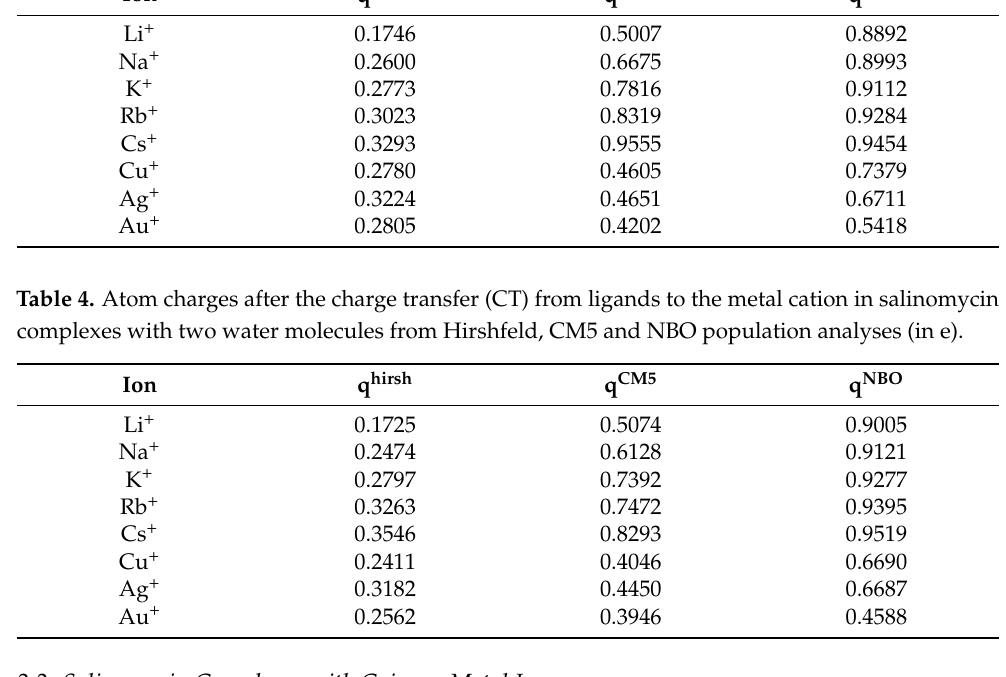
Table 3. Atom charges after the charge transfer (CT) from ligands to the metal cation in salinomycin complexes with one water molecule from Hirshfeld, CM5 and NBO population analyses (in e). Ion q hirsh q CM5 q NBO Li + 0.1746 0.5007 0.2600